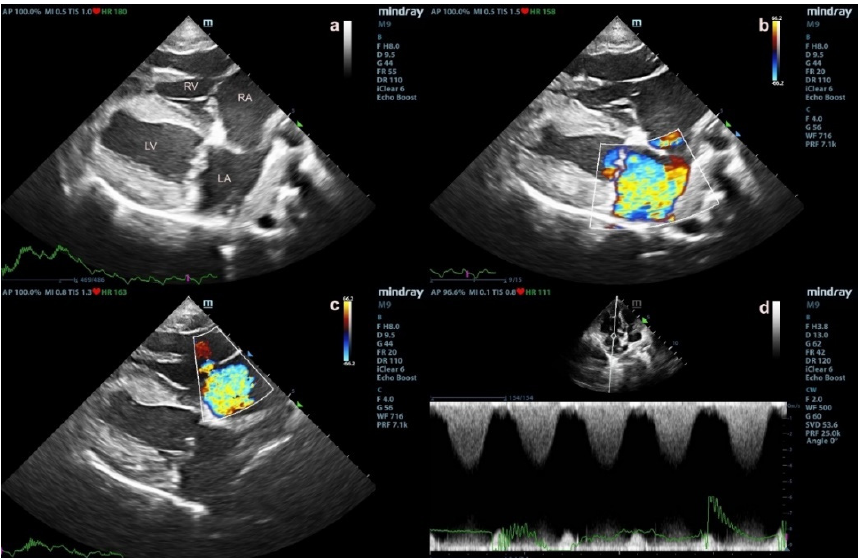
Figure 1. The echocardiographic findings of degenerative mitral valve disease (DMVD) dogs with pulmonary hypertension (PH) ( a – d ). Echocardiography from two-dimensional right parasternal four chamber view shows mitral valve thickening and left atrial (LA) enlargement ( a ). Color-flow Doppler echocardiography shows mitral valve ( b ) and tricuspid valve regurgitation jets ( c ). Spectral Doppler echocardiography shows peak systolic tricuspid regurgitation velocity ( d ).